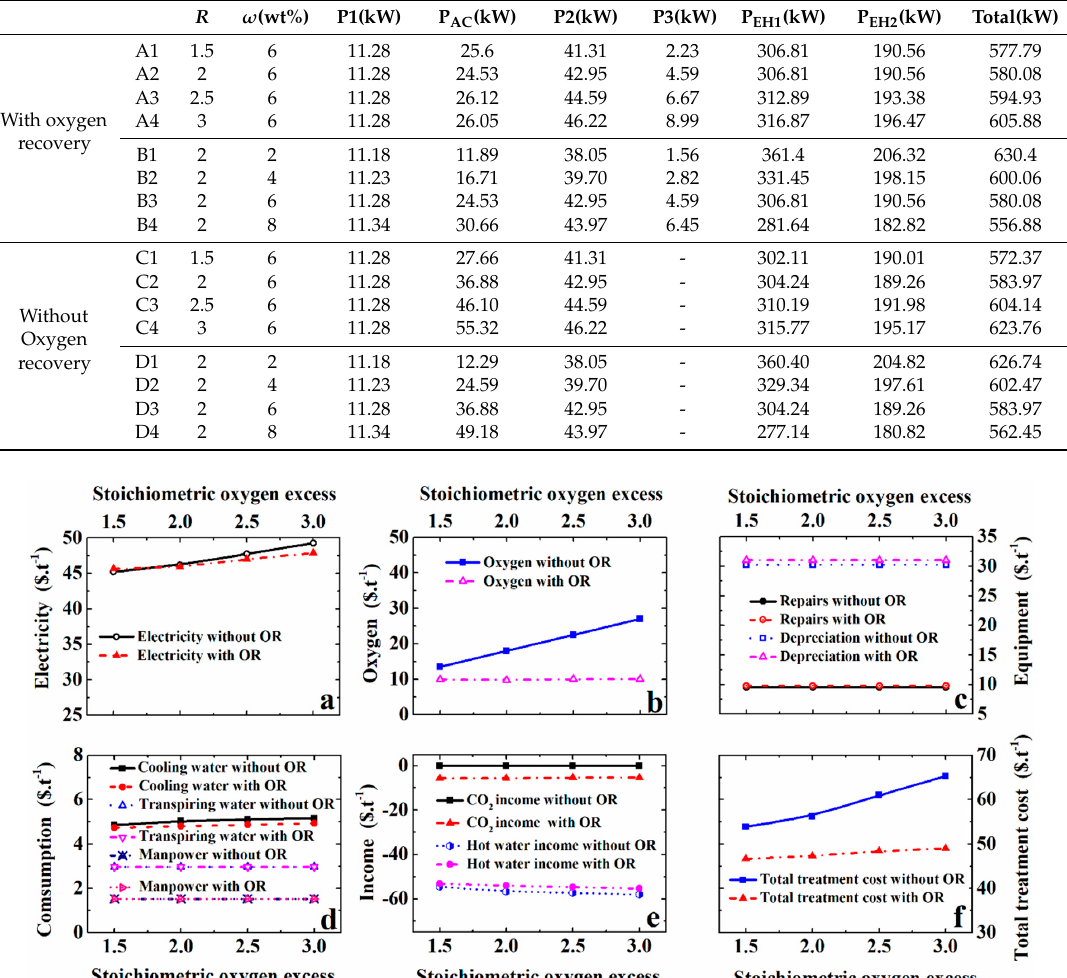
Table 7. Electricity consumption for the SCWO system.